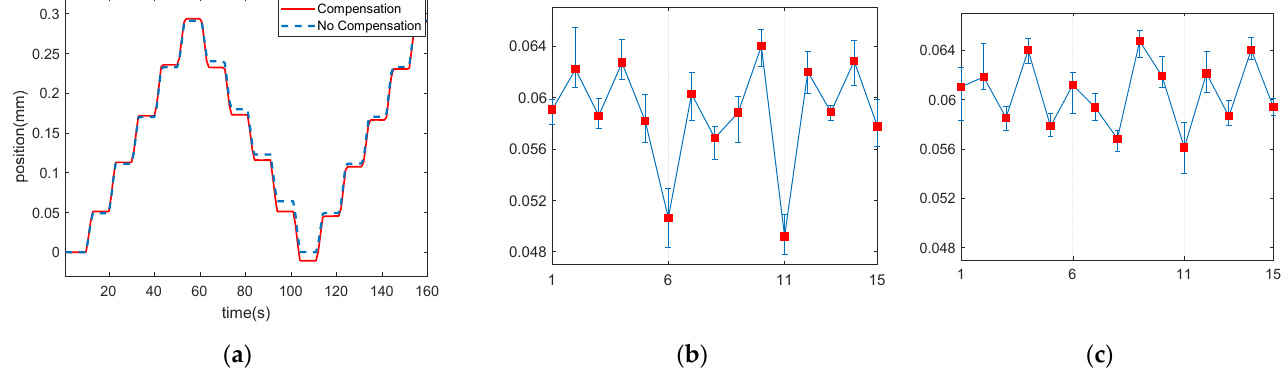
Figure 9. Result of the compensation experiment of the gap of the roller cartridge. ( a ) Position of the roller cartridge from the laser sensor with/without compensation. ( b ) Without compensation. ( c ) With compensation; the data include the median and range of measured errors for 20 trials.